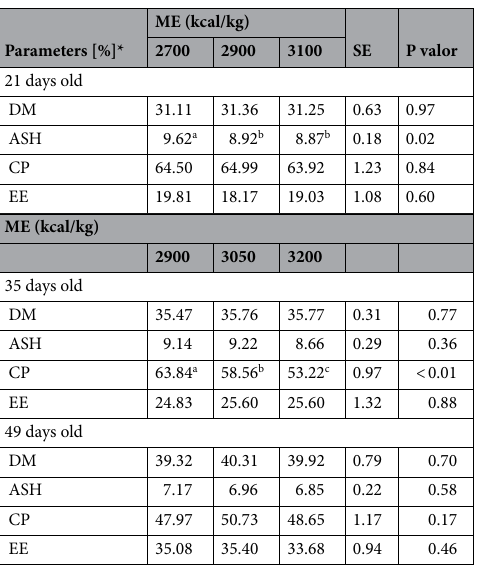
Table 4. Quail meat chemical composition as a function of different levels of metabolizable energy (ME). SE: Standard error of the mean; Means followed by different letters differ from each other by Tukey’s test at 5% probability. DM dry matter, CP crude protein, EE ether extract. *Values on based on natural matter.